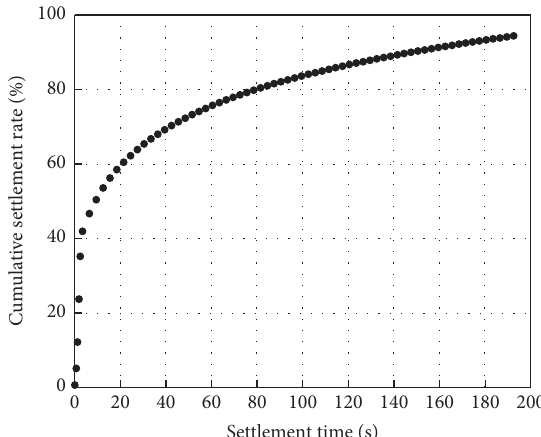
Figure 4: Sedimentation curve of flocculated microbeads.